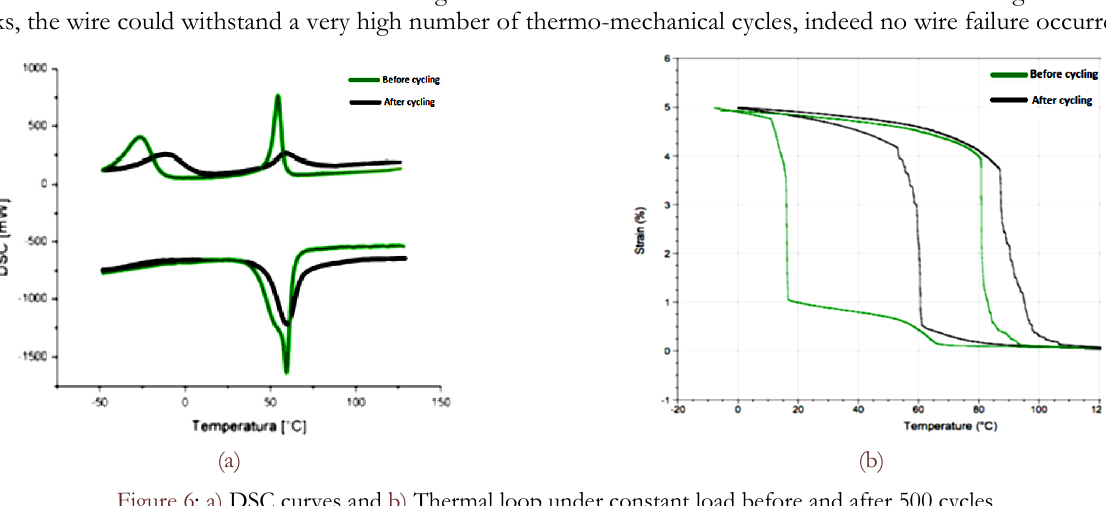
Figure 6: a) DSC curves and b) Thermal loop under constant load before and after 500 cycles